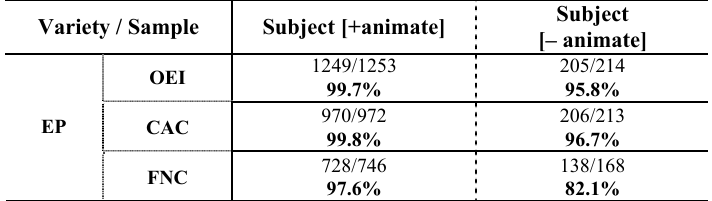
Table IV: Third person plural verbal marking in EP and Semantic feature of the subject Variety /